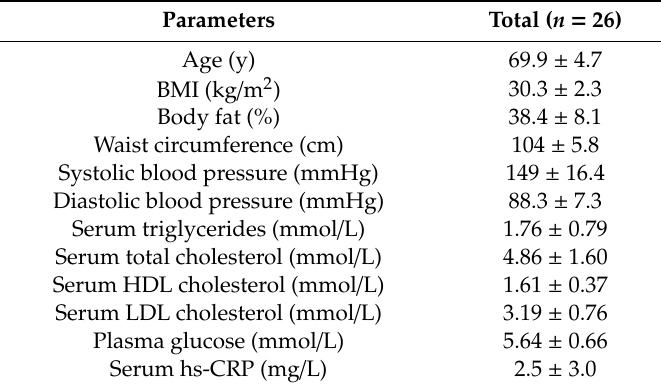
Table 2. Baseline characteristics of participants (adapted from [21]) 1 .